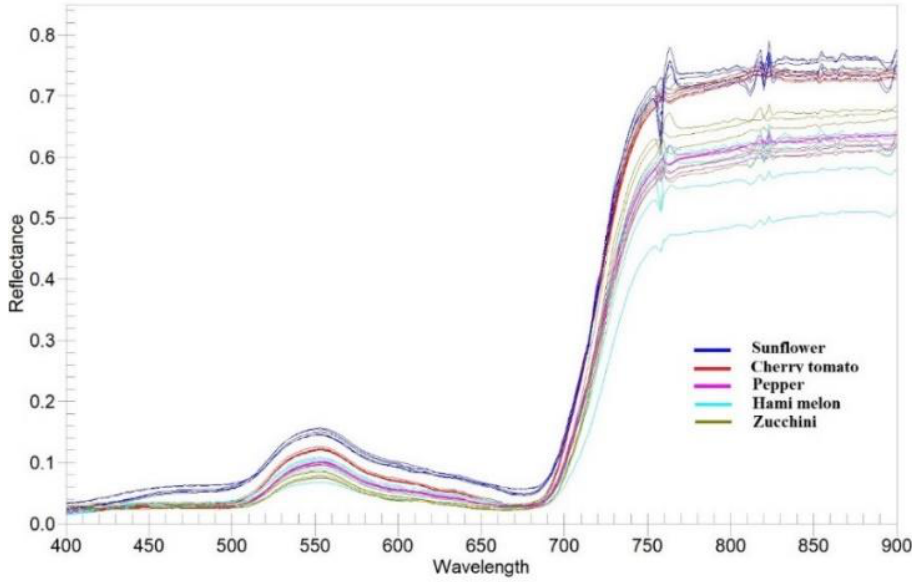
Figure 10. Spectral curve of ground